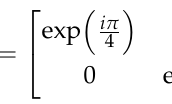
10% is 526–558 nm, and the bandwidth of the TM and TE linear polarized light with a phase difference of π /2 within 10% is 523–540 nm. Especially at the target wavelength of 532 nm, the transmittance is the same and the phase difference is approximately π /2, so the double orthogonal rectangular slots array at this size realizes the performance of a quarter ‐ wave plate. Meanwhile, the simulation results also demonstrate that the coupling between the double orthogonal rectangular slots has a small effect on its performance.